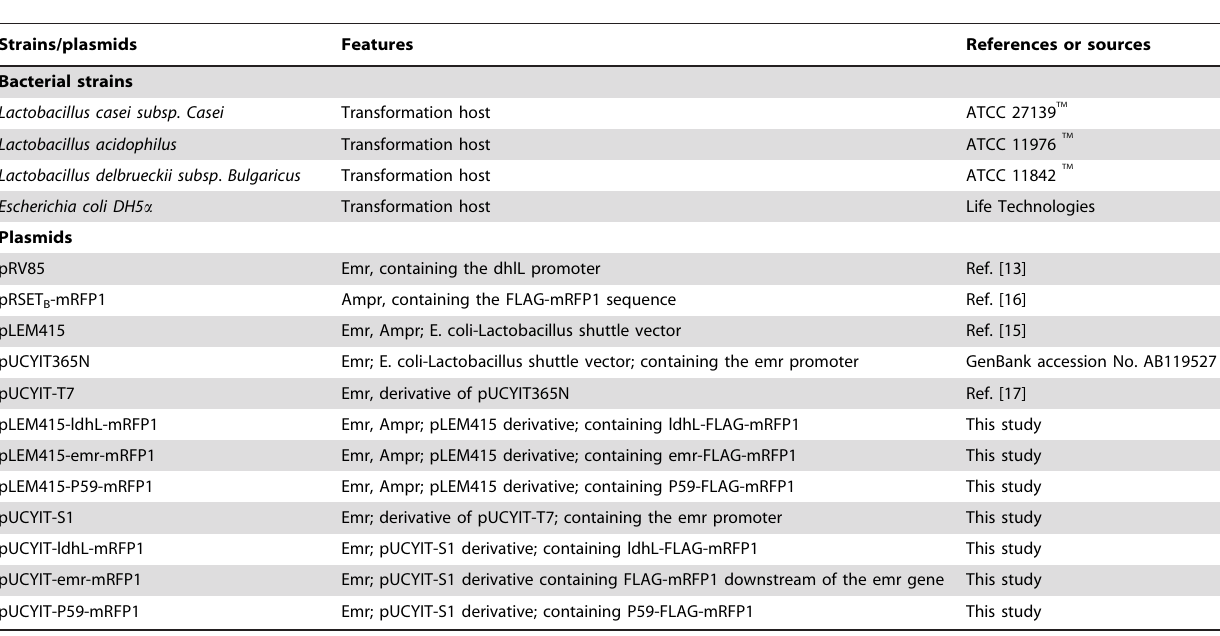
Table 1. Summary of bacterial strains and plasmids used in this